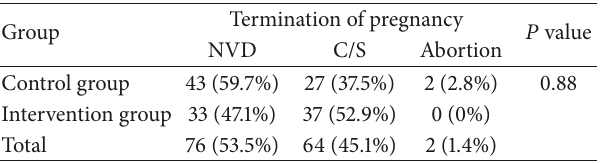
Table 2: Comparison of pregnancy types and end of pregnancy for intervention and control groups.